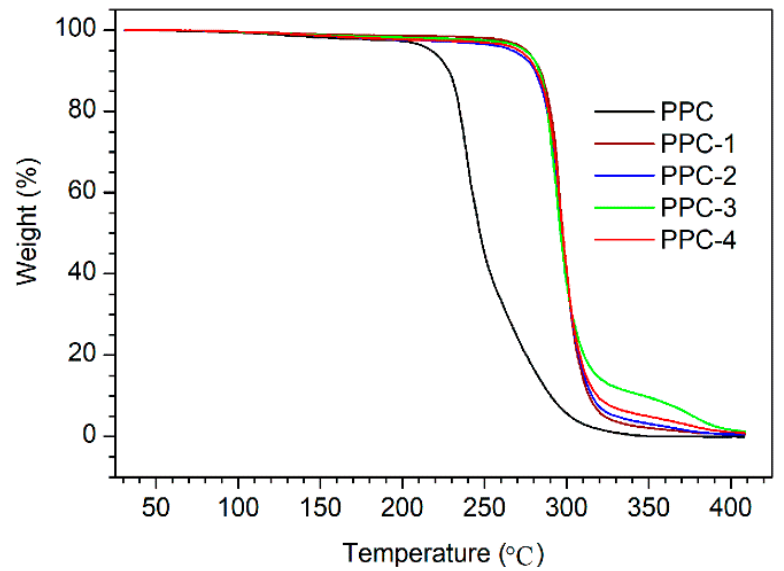
Figure 1. The thermogravimetric analysis (TGA) curves for PPC and PPC with networks.